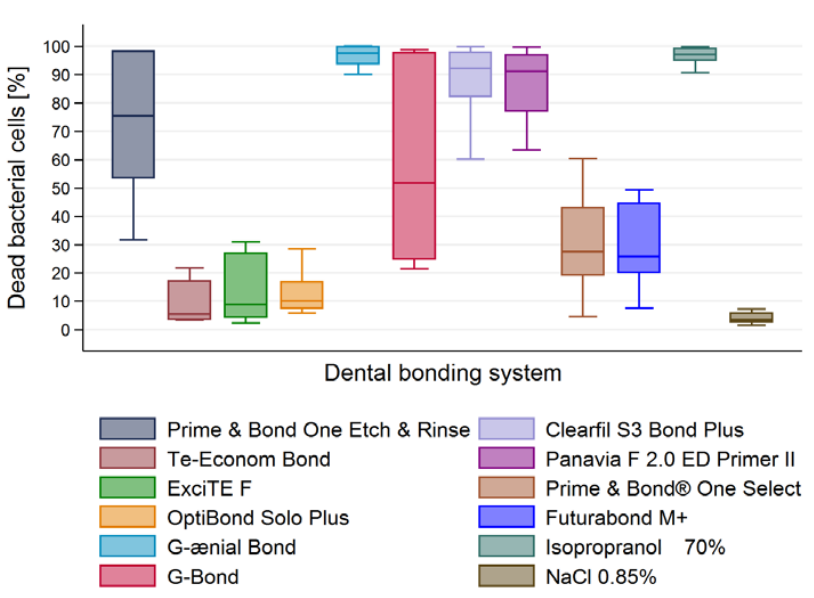
Figure 4. Assessment of dead bacterial cells [%] after incubation with all tested DBS.